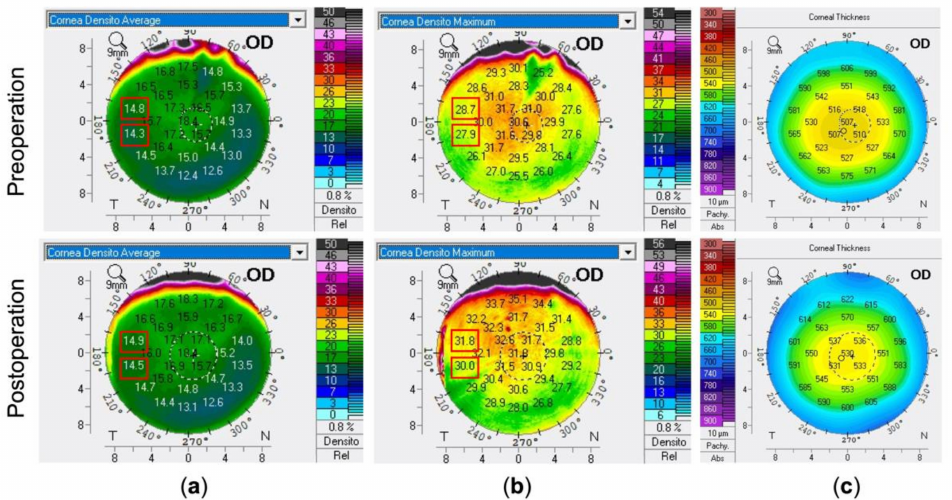
Figure 1. Densitometry and pachymetry maps. ( a ) Average densitometry map for obtaining the mean optical densities at different zones of cornea. ( b ) Maximal densitometry map for observing the maximal optical densities at different zones of cornea. ( c ) Pachymetry map for assessing the mean corneal thickness at varied sites of cornea. For the temporal approach of cataract surgery, the values highlighted with the two red rectangles were averaged to obtain the corneal optical density at the incisional site.